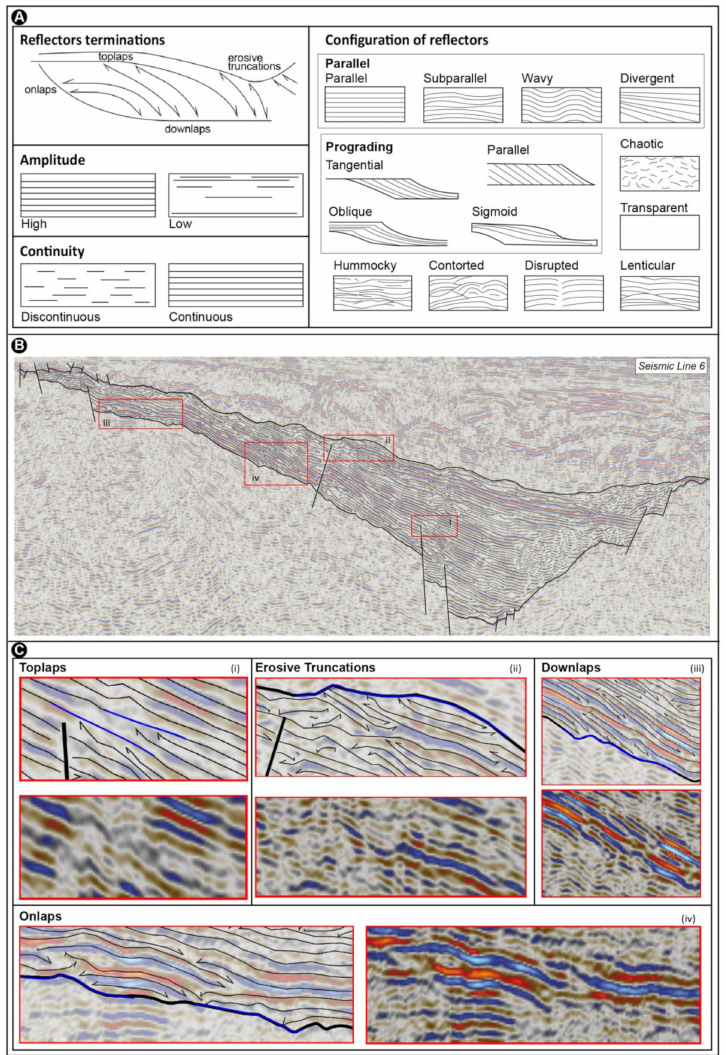
Figure 3. Summary chart for reflector termination analysis. ( A ) Types of terminations, amplitude, continuity and configuration of the reflectors. ( B ) Example of studied seismic line with interpretation of reflectors. ( C ) Detailed view of types of reflector terminations found: ( i ) toplaps, ( ii ) erosive truncations, ( iii ) downlaps and ( iv )